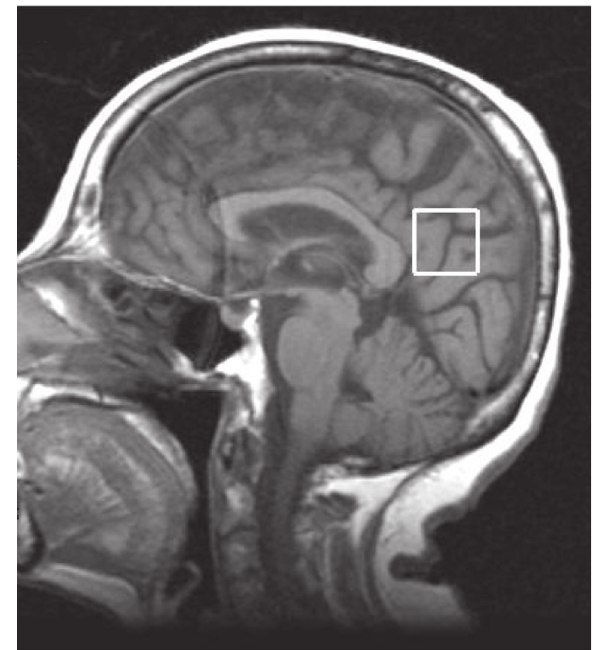
Figure 1. Sagittal T1-weighted image (TR=450 ms, TE=8 ms), showing voxel in the posterior